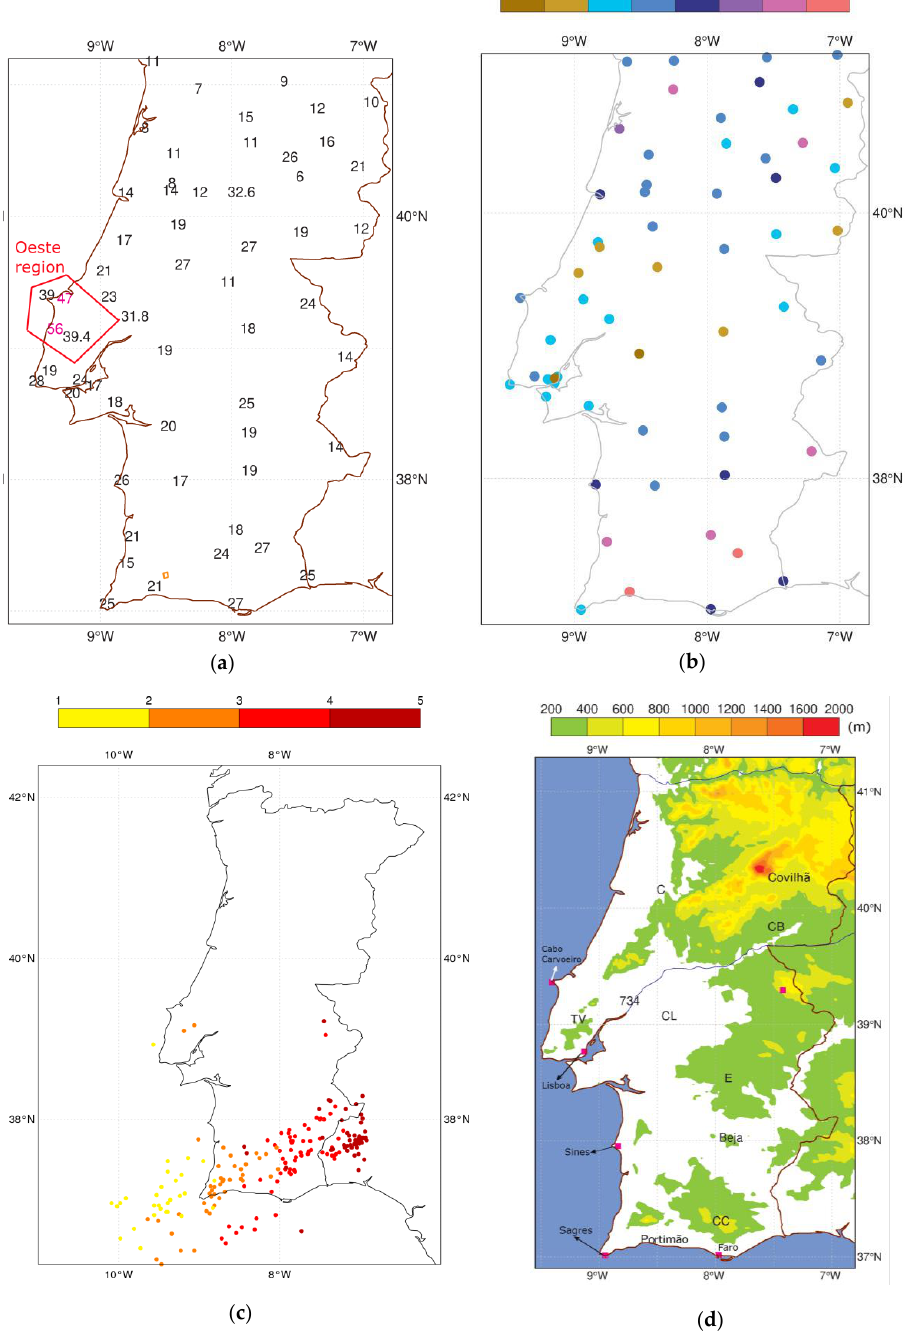
Figure 1. Observations in the period between 00:00 UTC and 06:00 UTC on 23 / 12 / 2009. ( a ) Maximum 10-m wind gust (m s − 1 ) recorded at IPMA stations (black) and other stations (magenta); ( b ) Accumulated precipitation between 00:00 UTC and 06:00 UTC (mm); ( c ) Time (UTC) of the lightning in the period between 01:00 UTC and 05:00 UTC; ( d ) Orography and locations of some IPMA weather stations, where C, CB and TV indicate the locations of Coimbra, Castelo Branco and Torres Vedras, respectively. Locations of the radars CL and CC are also marked. In ( a ), the Oeste region, where severe damages occurred, is marked, and the orange polygon in the south identifies the locations of damages in power towers.